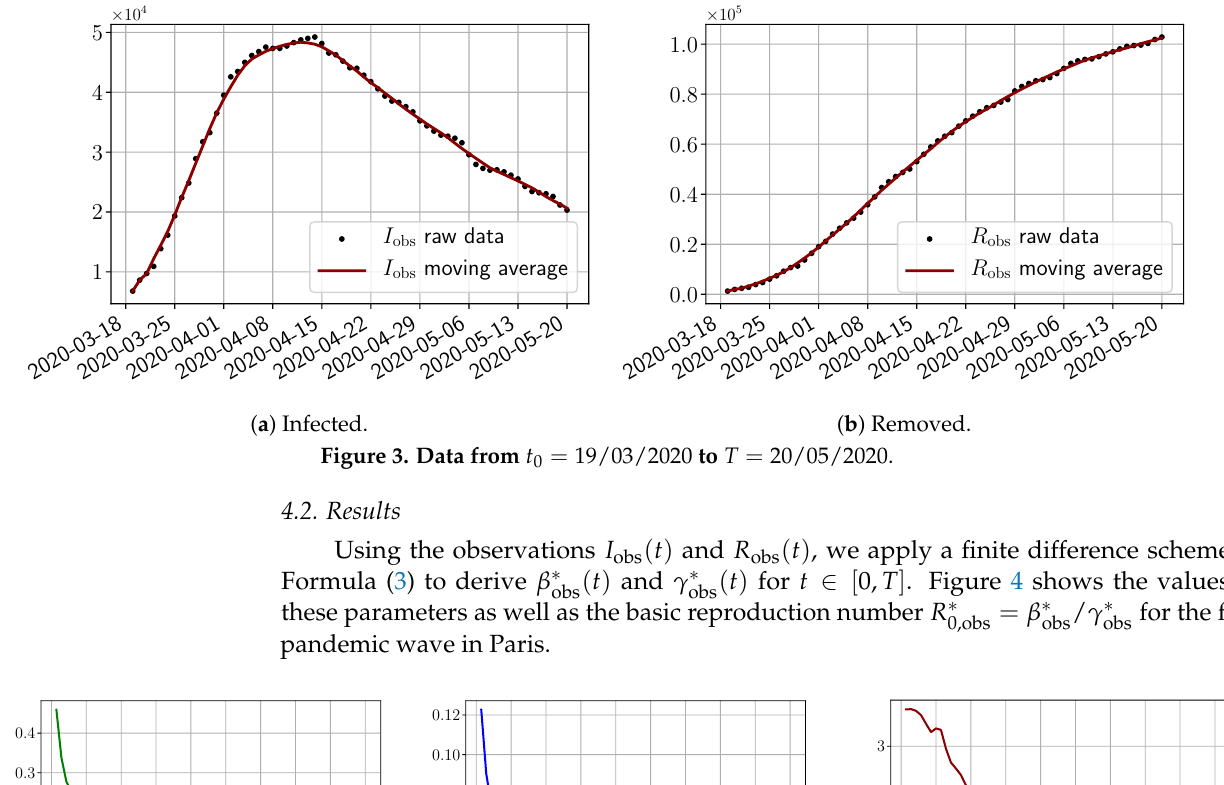
Figure 3. Data from t 0 = 19/03/2020 to T = 20/05/2020.